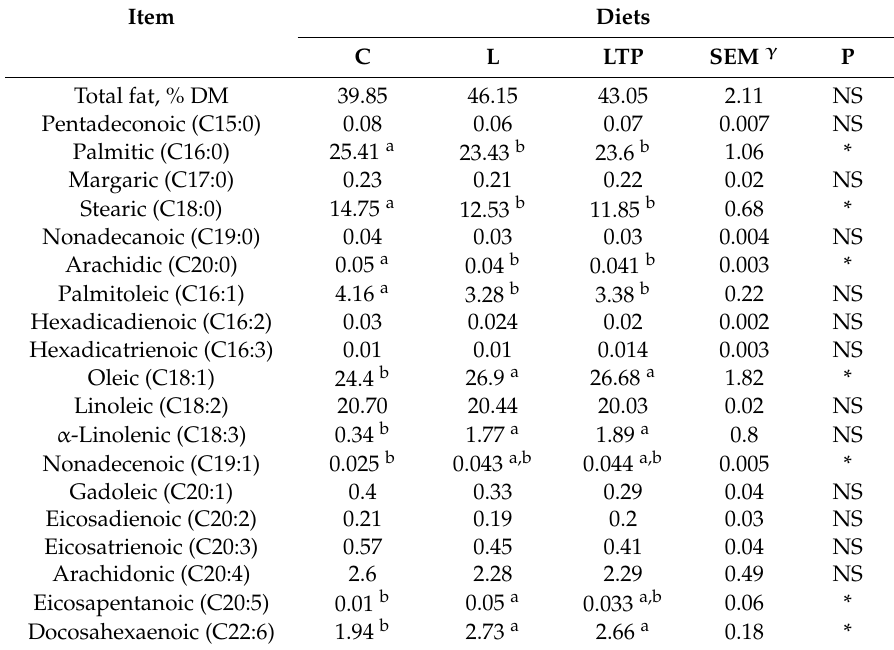
Table 2. Fatty acids composition (% of total fat) of egg yolk $